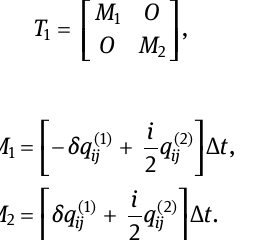
Figure 19. The stability of the proposed method here is discussed via the matrix method and the graphical representation is provided in Figures 20 and 21, respectively. These fi gures indicates that obtained eigen values are within the prescribed range. It stable.